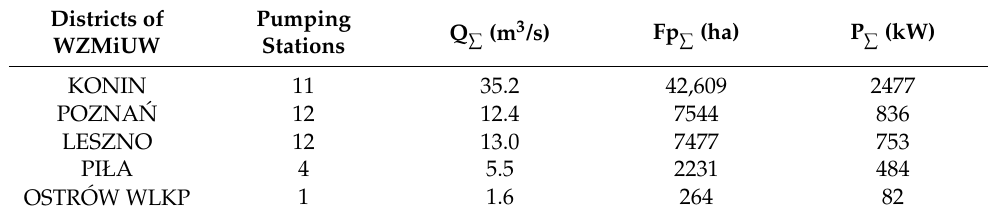
Table 2. Details of the analyzed drainage pumping stations according to WZMiUW.